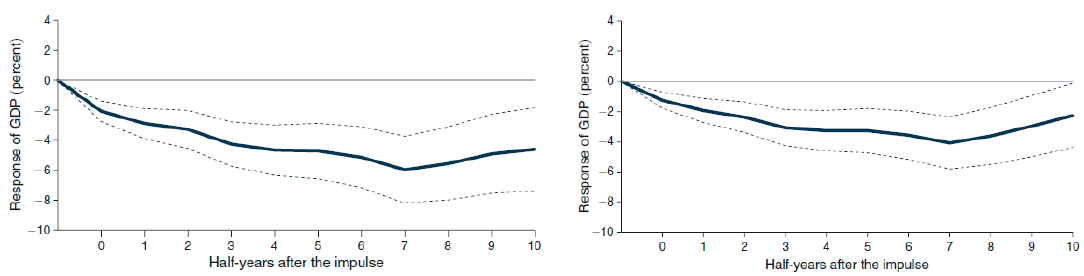
Figure 1. Cost of crisis using Romer and Romer (2017a). Source: Romer and Romer (2017a), p. 3095 and p. 3100. Copyright American Economic Association; reproduced with permission of the American Economic Review .